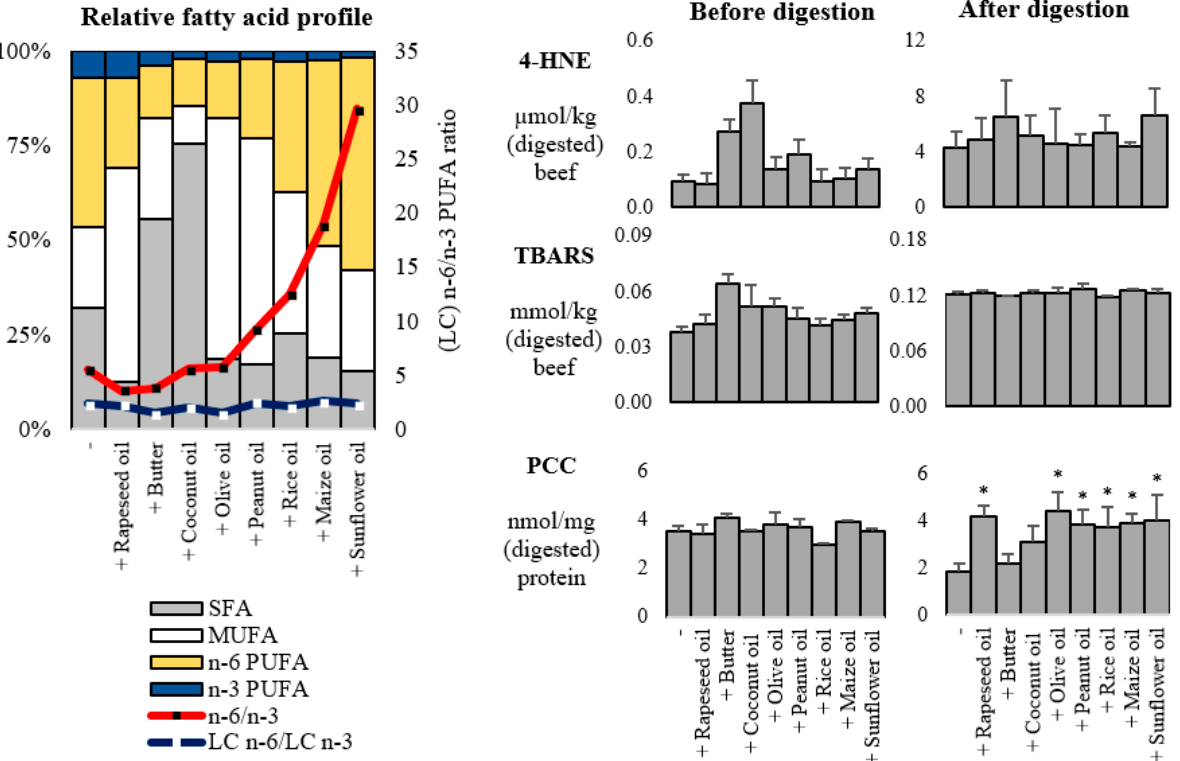
Figure 3. The relative fatty acid profile ( Left ) of beef with or without butter or commercial vegetable oils, and oxidation products ( Right ) 4-HNE (4-hydroxy-2-nonenal), TBARS (thiobarbituric acid reactive substances) and PCC (protein carbonyl compounds) before and after in vitro digestion (Experiment 2). Error bars indicate standard deviation. Asterisk (*) indicates that the treatment with added fat substrate is significantly different ( p < 0.05) compared to the beef without added